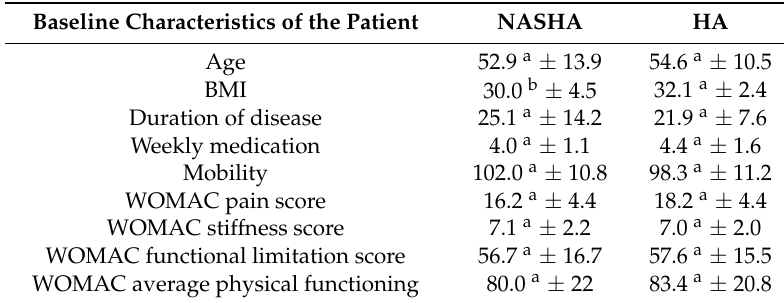
Table 2. Patient data record on the first visit. Different letter within the same row stands for significant differences ( p < 0.05, One way